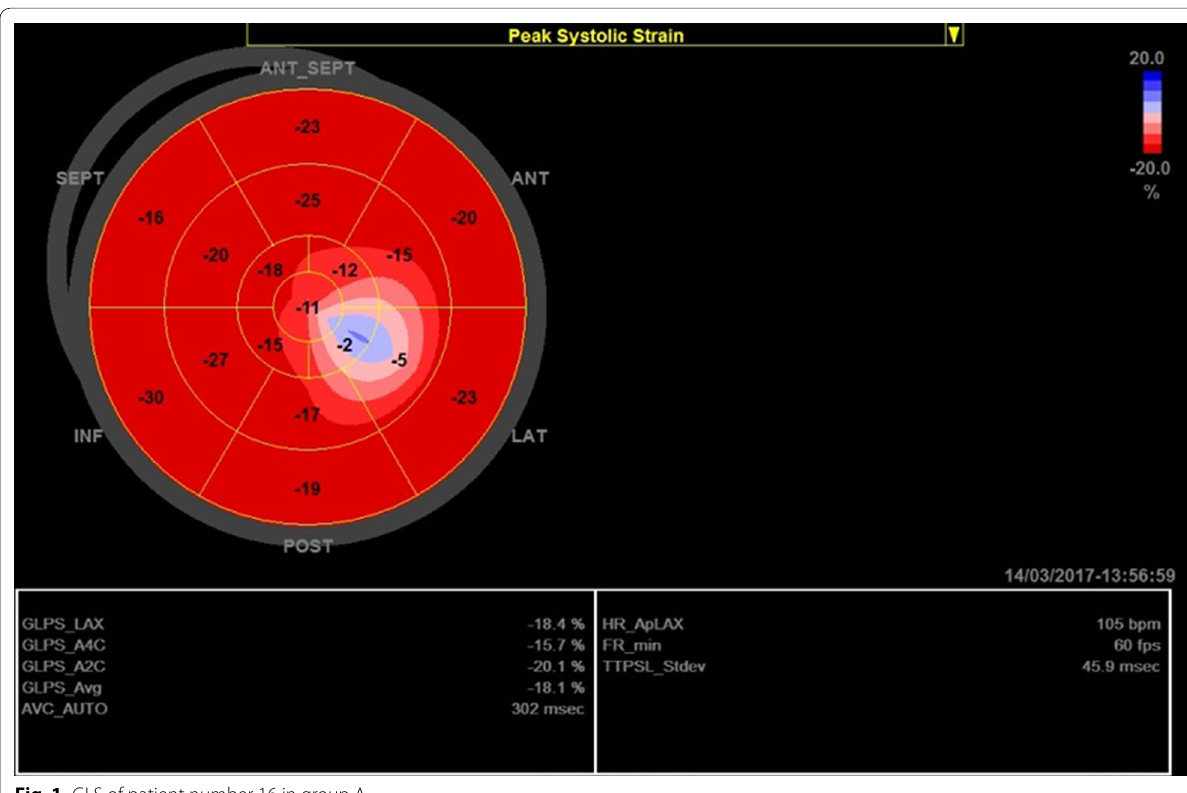
Fig. 1 GLS of patient number 16 in group